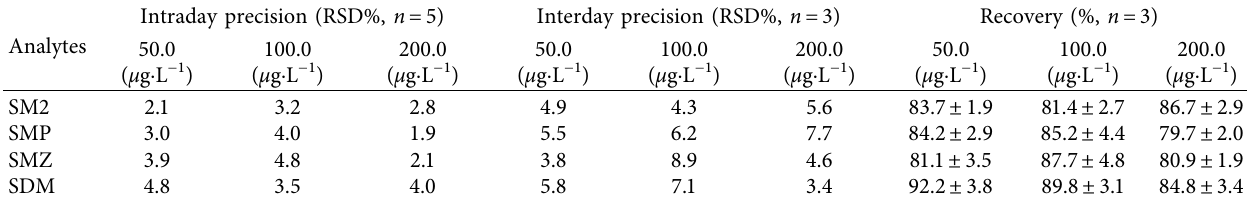
Table 5: Precisions and recoveries for the determination of SAs in water samples.